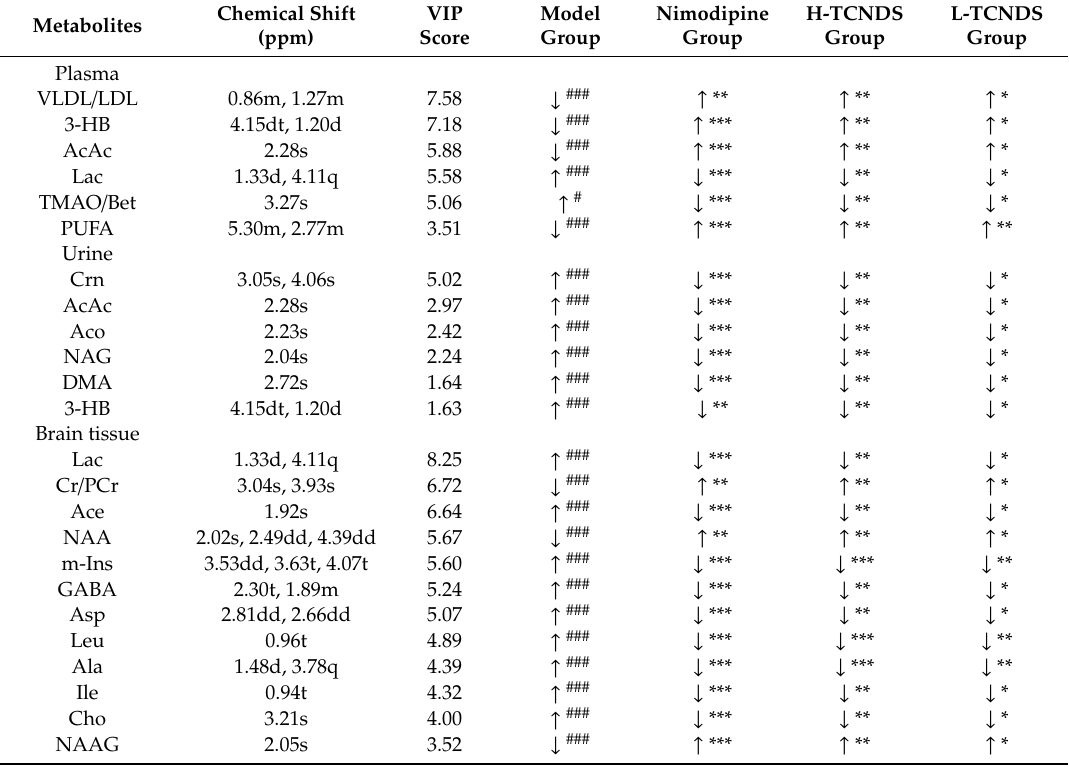
Table 3. Discriminatory metabolites and their changes in plasma, urine, and brain tissue. Metabolites